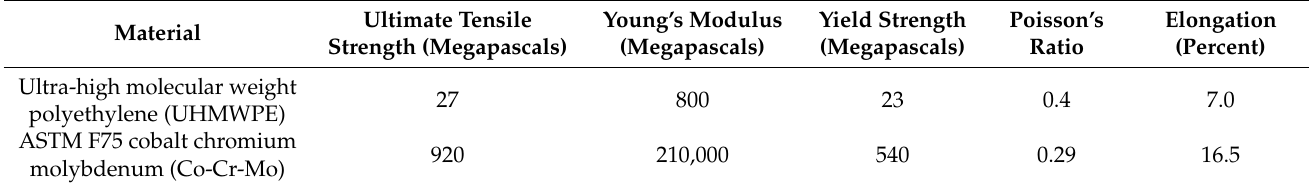
Table 2. Mechanical properties of materials used in this study [43–46].